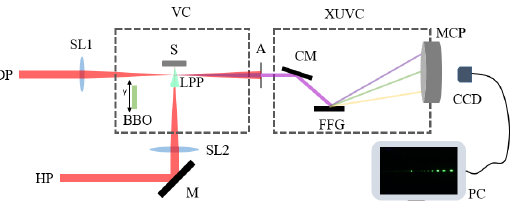
Figure 1. Schematics of experimental setup. DP, driving pulse; HP, heating pulse; SL1, spherical lens with a 500 mm focal length; SL2, spherical lens with a 200 mm focal length; BBO, 0.2 mm thick type I beta barium borate crystal; M, mirrors; S, samples; LPP, laser-produced plasma; VC, target vacuum chamber; XUVC, coherent extreme ultraviolet (XUV) vacuum chamber; A, slit; CM, cylin- drical mirror; FFG, flat field grating; MCP, micro-channel plate; CCD, CCD camera; PC, personal